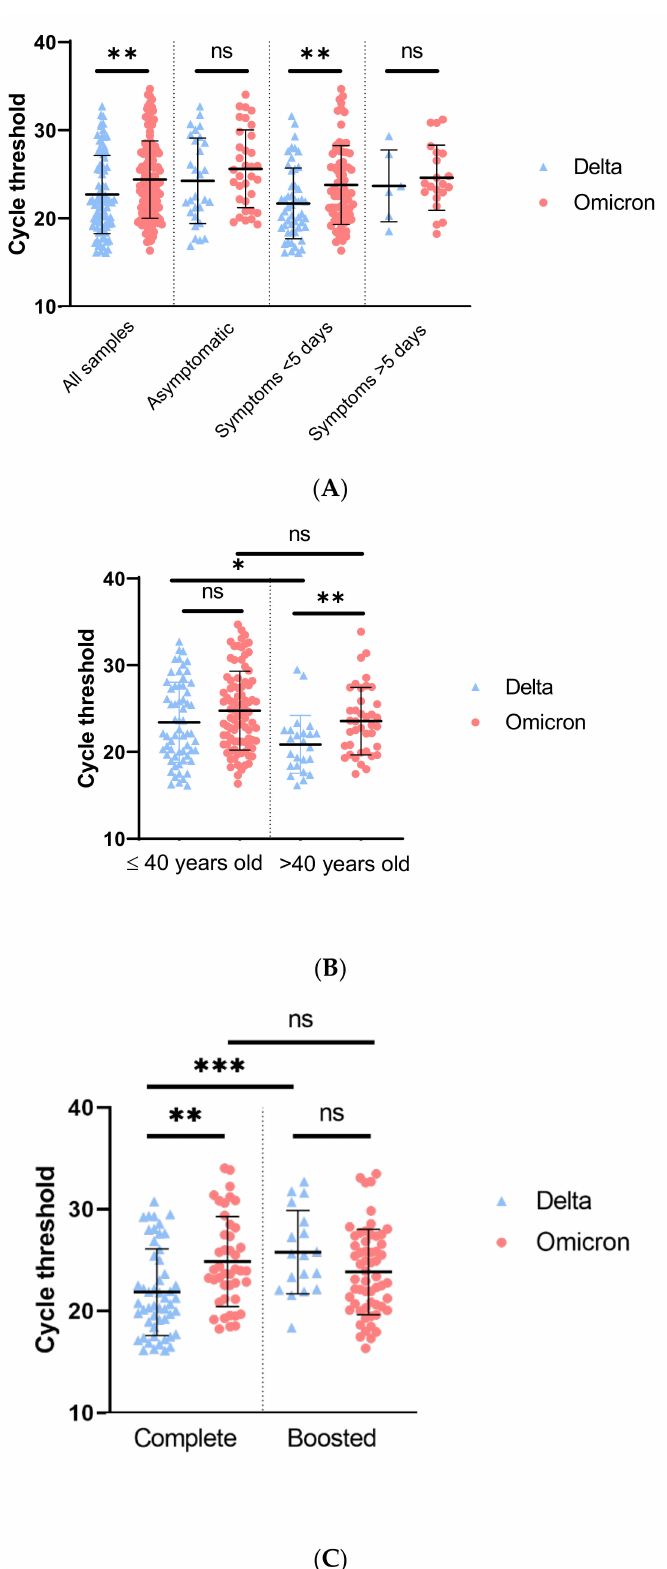
Figure 1. RT-PCR cycle threshold values for Delta or Omicron. ( A ): Cycle threshold of Delta or Omicron variant according to symptoms. Global analysis included all samples (Delta, n = 85, Omicron, n = 129). Asymptomatic patients (Delta, n = 28 and Omicron, n = 34), symptoms appearing less than 5 days prior sampling (Delta, n = 51 and Omicron, n = 74) and symptoms appearing more than 5 days prior sampling (Delta, n = 6 and Omicron, n = 21). ( B ): Cycle threshold of Omicron or Delta